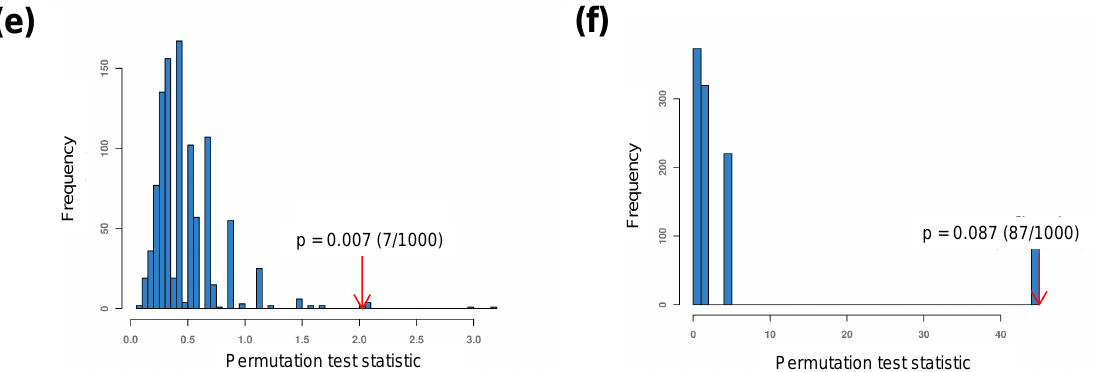
Figure 5. PLS-DA analyses of metabolic profiling with 28 and 41 metabolites. ( a ) Score plots of PLS-DA with 28 metabolites (R 2 X = 0.603). ( b ) Score plots of PLS-DA with 41 metabolites (R 2 X = 0.383). ( c ) Cross-validation results of PLS-DA with 28 metabolites (components = 5, R 2 Y = 0.95, Q 2 Y = 0.62). ( d ) Cross-validation results of PLS-DA with 41 metabolites (components = 5, R 2 Y = 0.94, Q 2 Y = 0.49). ( e ) 1000 random permutation tests in PLS-DA with 28 metabolites ( p = 0.007).